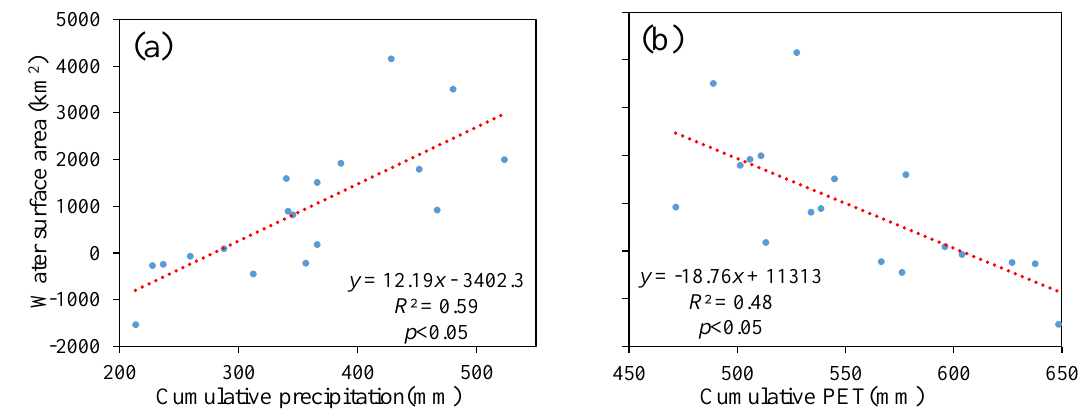
Figure 10. The relationship of changes in water surface area between April – September with ( a ) cumulative precipitation during the period and ( b ) cumulative potential evapotranspiration (PET).